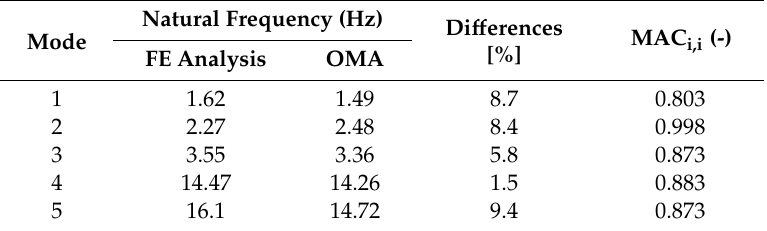
Table 2. Comparison of the numerical and experimental natural frequencies of the viaduct.